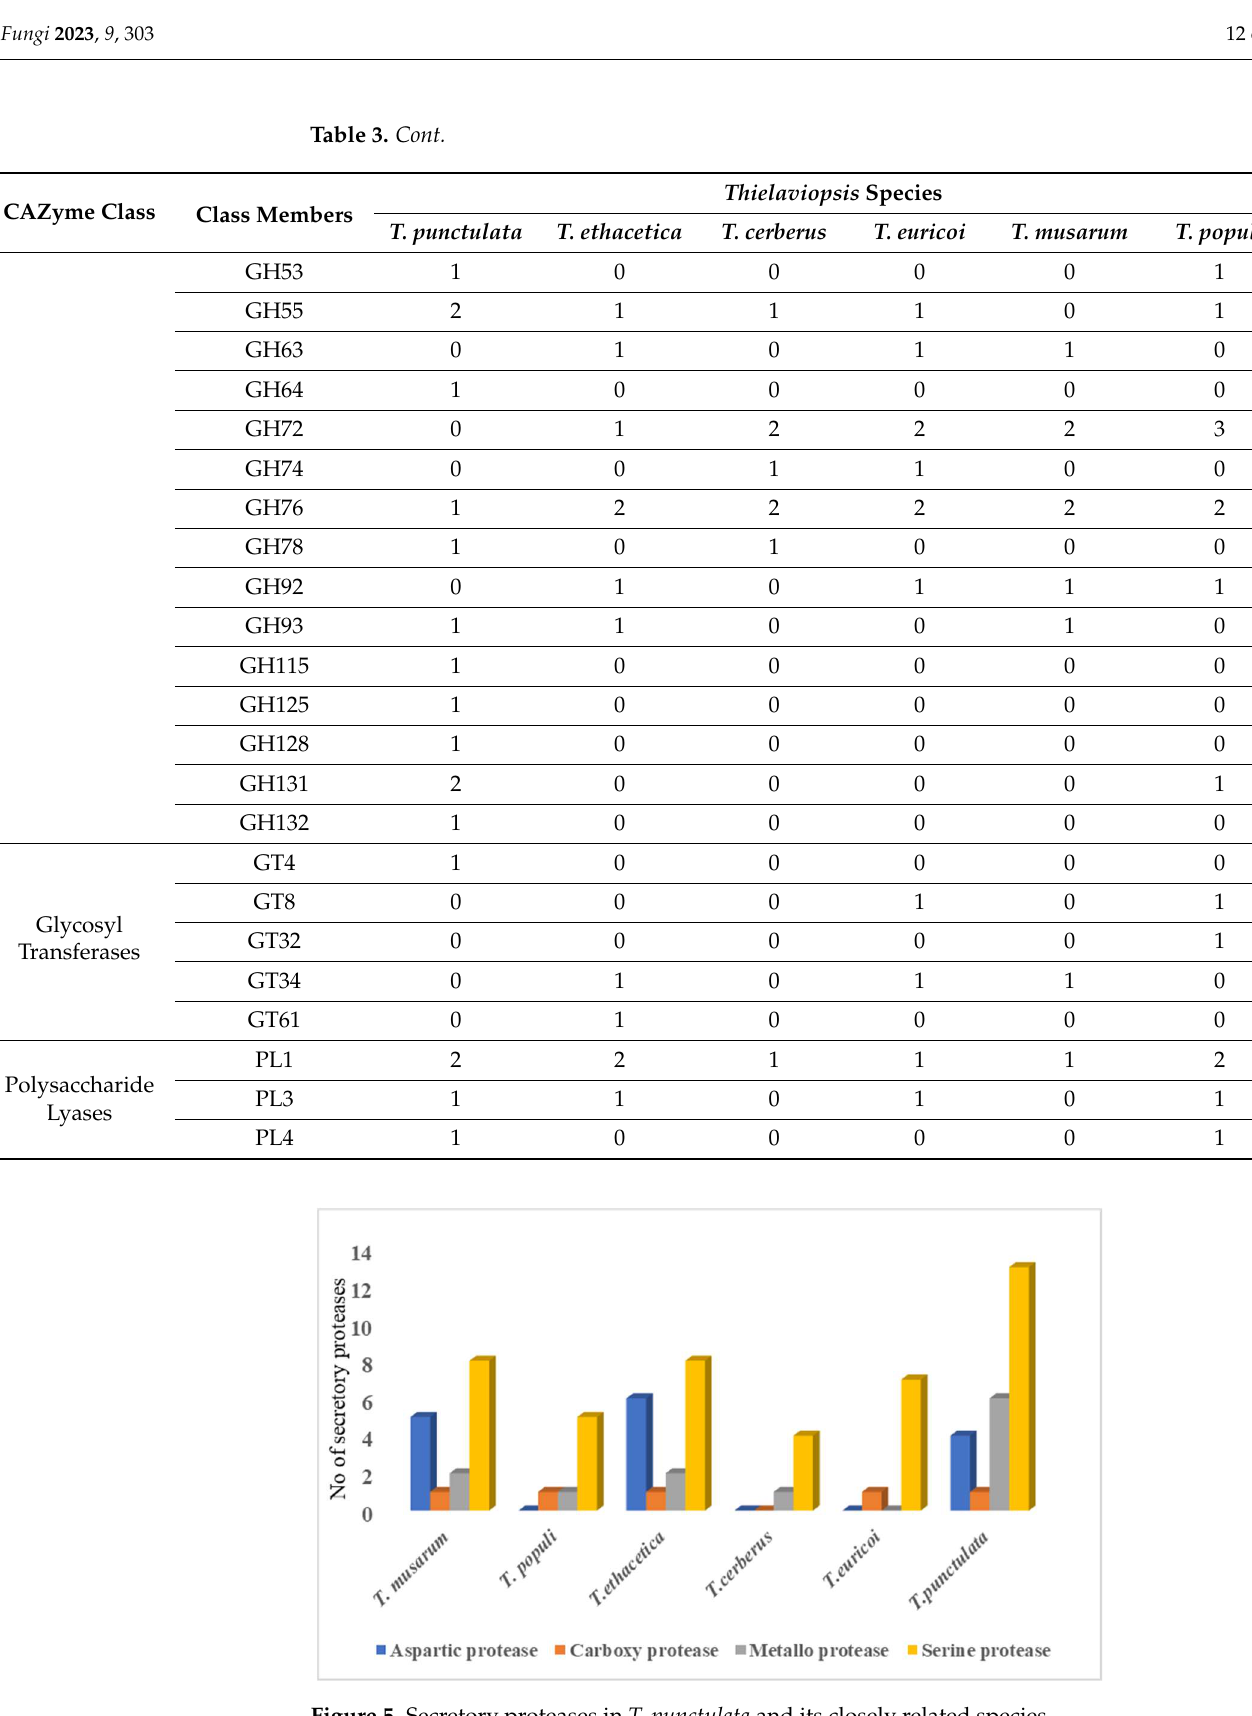
Figure 5. Secretory proteases in T. punctulata and its closely related species.